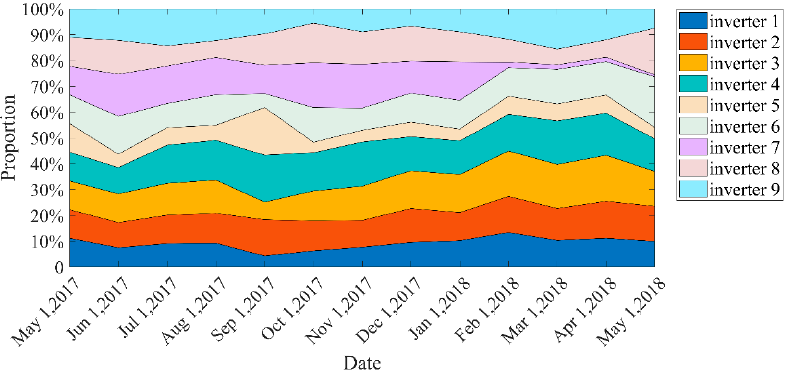
Figure 9. Proportion of times that different inverters were chosen as the center inverter.